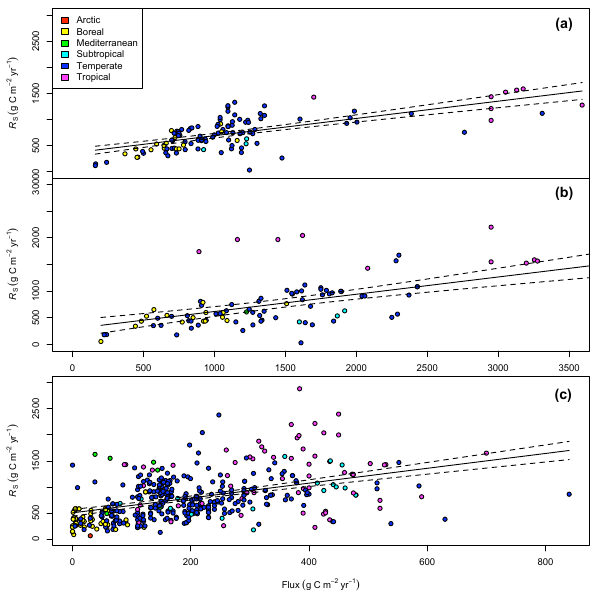
Fig. 5. Correlation between annual soil respiration ( R S ) and other carbon fluxes: (a) annual ecosystem respiration, (b) annual gross primary production, and (c) annual aboveground litter flux, by biome. Solid lines show linear regression fit; dashed lines are 95% confidence intervals. Regressions shown are (a) y = 361 + 0 . 33 x , N = 116, R 2 = 0 . 48; (b) y = 296 + 0 . 32 x , N = 92, R 2 = 0 . 33; (c) y = 502 + 1 . 43 x , N = 421, R 2 = 0 . 21.